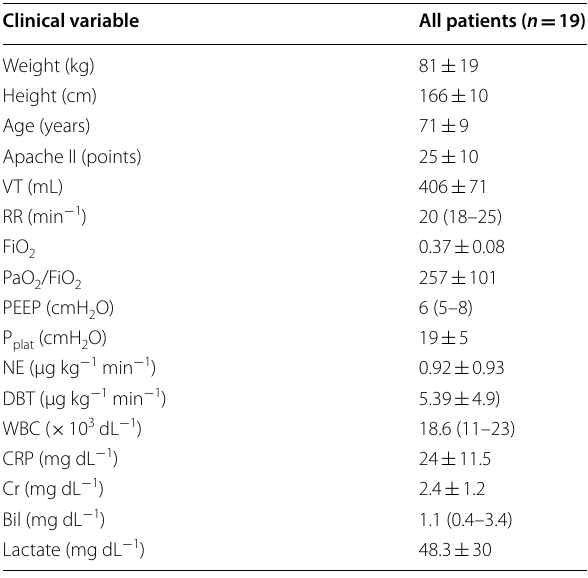
tional file 1: Figure S1). Case demographics and clinical file 1: Table S1. Baseline haemodynamic